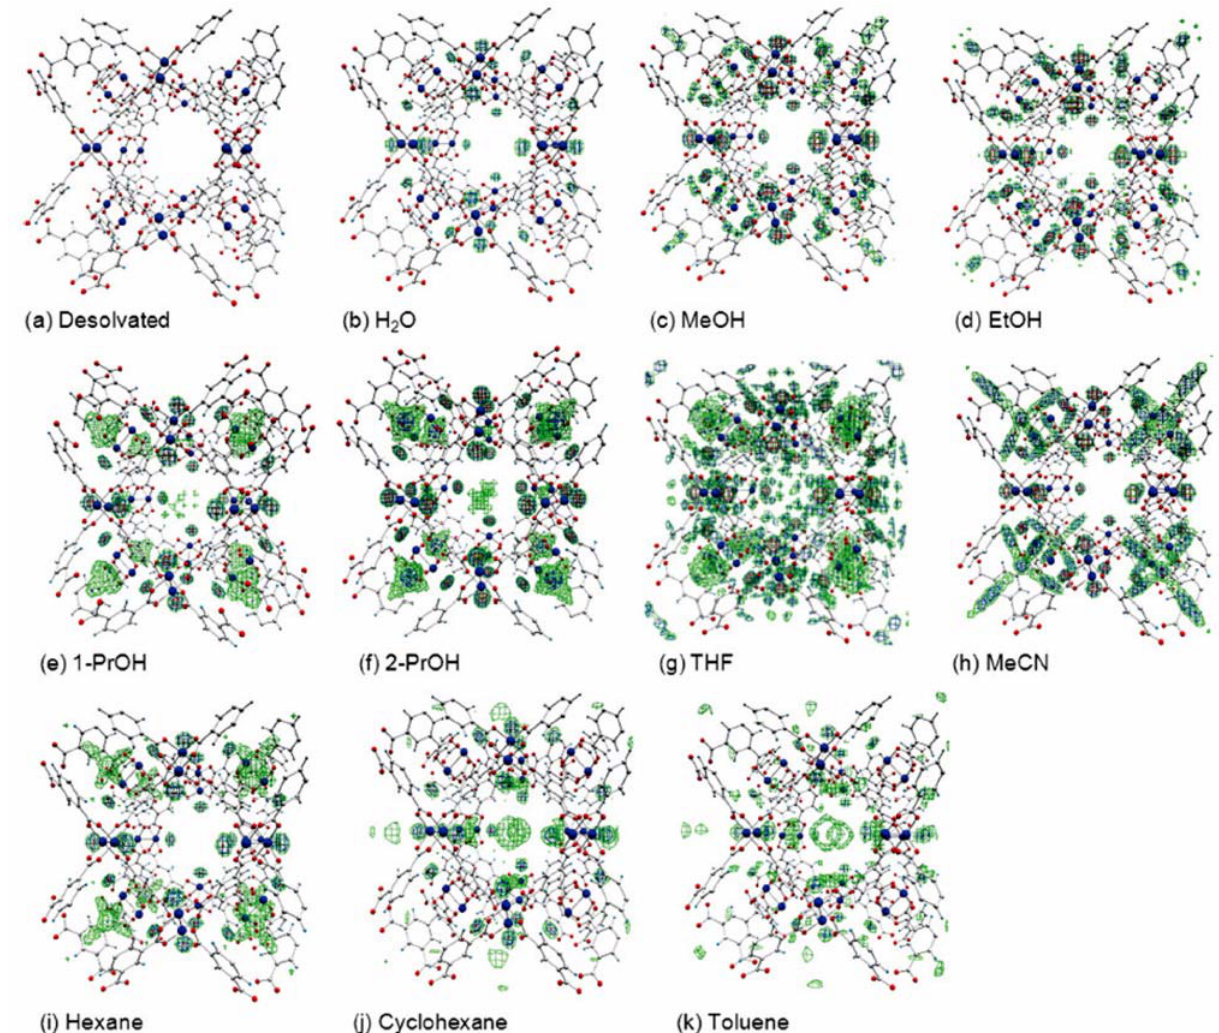
Figure 5 : Residual electron density maps for Cu (BTC) (guest)n·x(guest), where guest = none (a), H2O (b), MeOH (c), EtOH (d), 1-PrOH (e), 2- 3 2 PrOH (f), THF (g), MeCN (h), hexane (i), cyclohexane (j), and toluene (k). Green = 0.7, blue = 1.1, and red = 2.4 e-Å-3. Coordinated guests have been omitted from the framework model, enabling identification of the guest bound at the Cu site. Shown are Cu (blue), O (red), C (gray), and H (pale blue). 91 Reprinted with permission. Copyright American Chemical